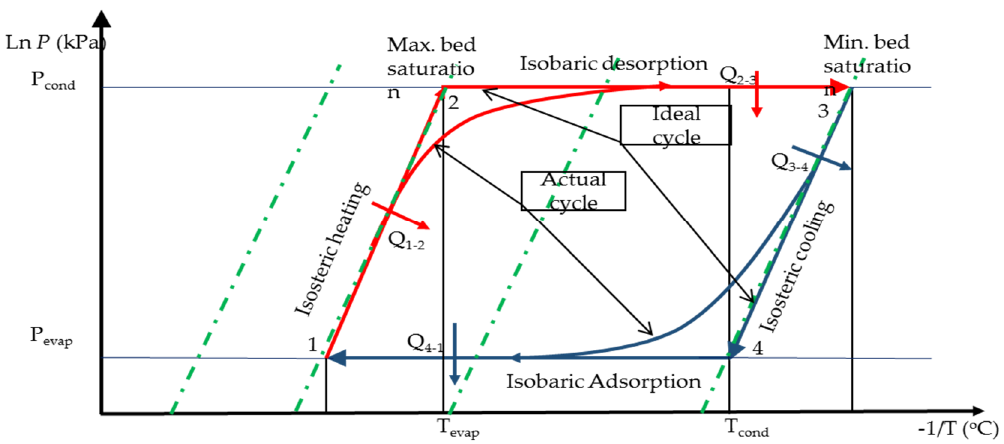
Figure 7. P–T- ω diagram of ideal and actual ADD cycle (1 → 2 isosteric heating, 2 → 3 desorption, 3 → 4 isosteric cooling, 4 → 1 adsorption).